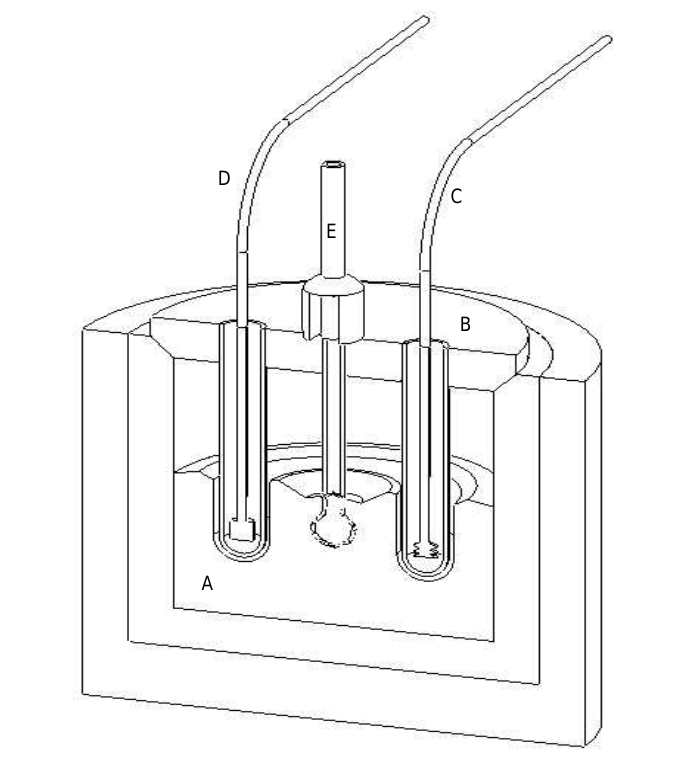
Figure 1. Diagram of the isoperibolic calorimetric